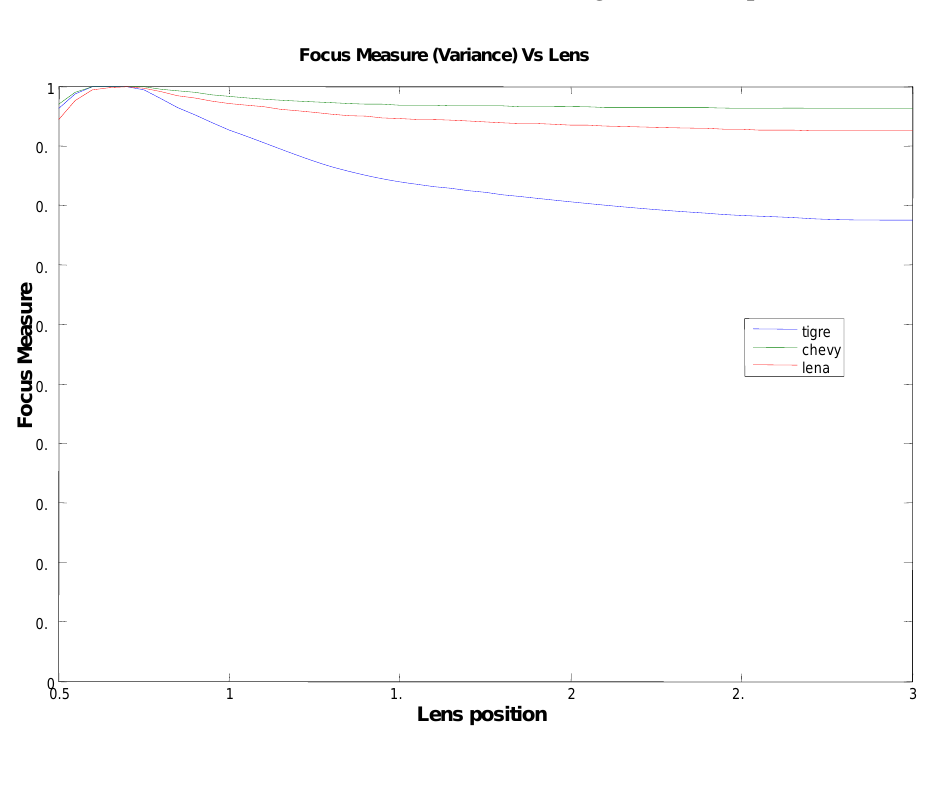
Figure 7. Focus measure for different images and lens